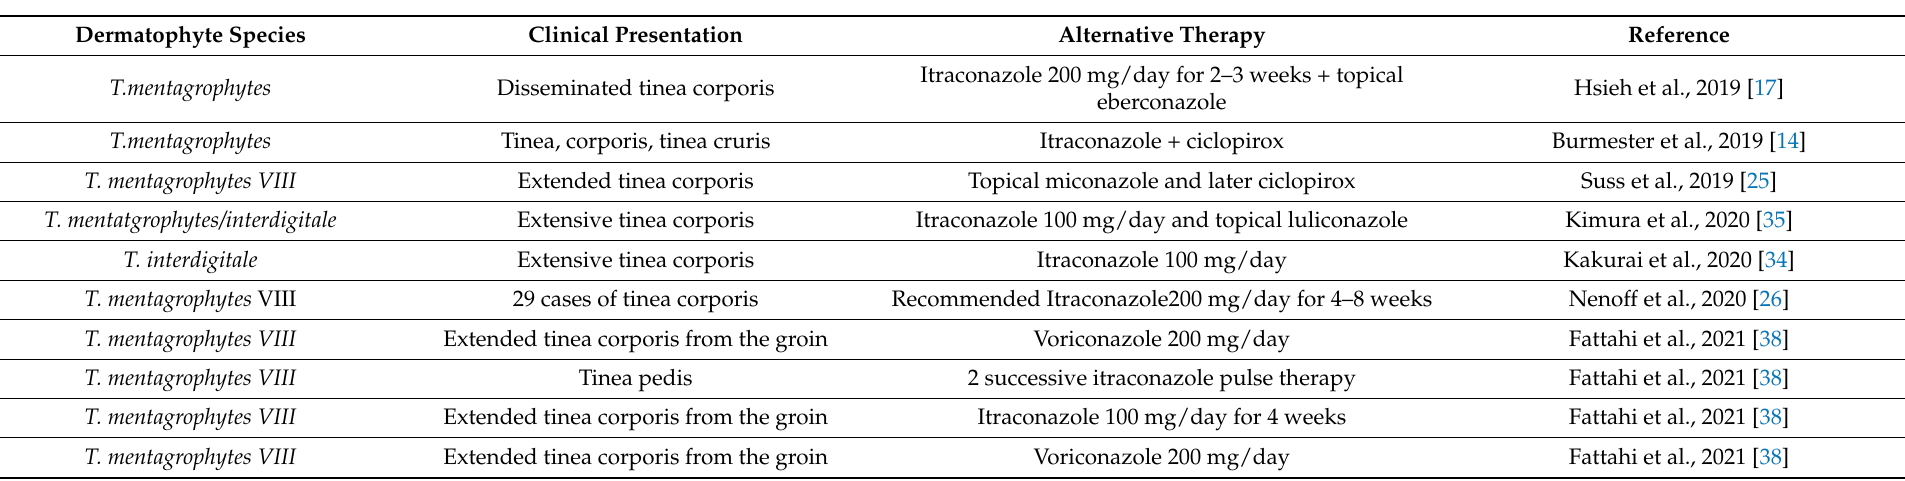
Table 3. Alternative therapies following clinical presentations for terbinafine resistant T. mentagrophytes/indotineae